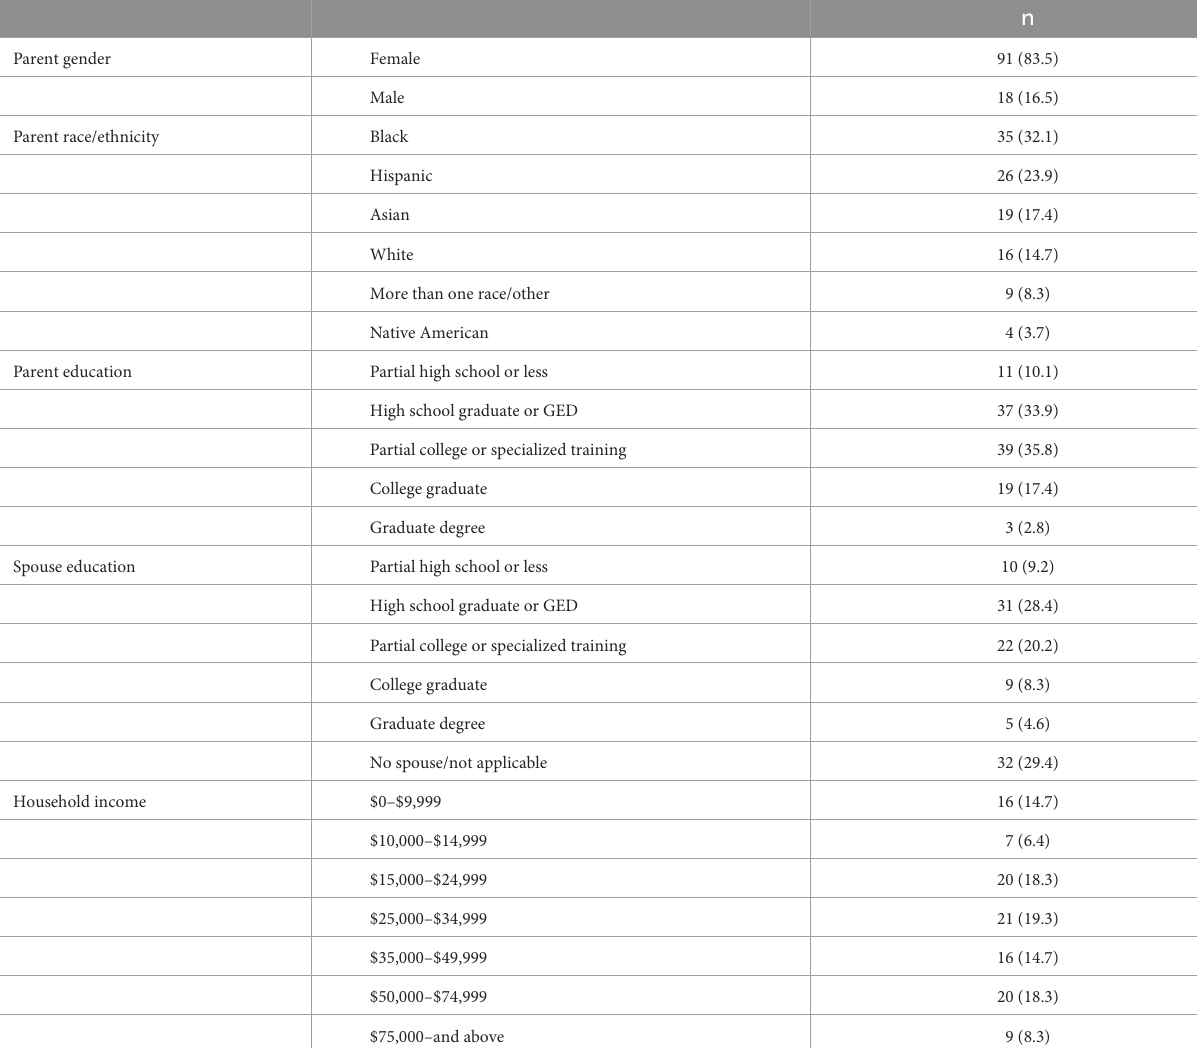
TABLE 1 Study demographic characteristics ( n =